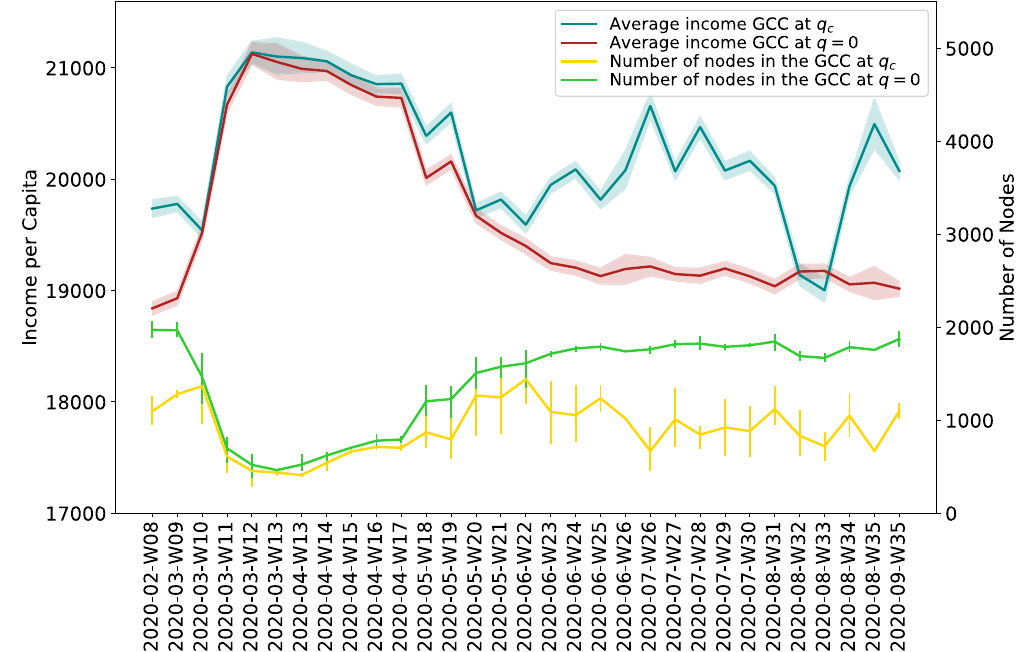
Figure 8. Average income per capita and total number of nodes in the GCC for every week of the period of observation. The GCC is either calculated at the start of the percolation process, i. e. without removing any nodes (GCC at q = 0 , red and green lines), or it is obtained by removing edges incrementally by weight until the optimal q is reached but before the GCC is dissolved (GCC at q c , blue and yellow lines). The lines represent the mean value of income per capita of the nodes or the total number of nodes in the GGC, averaged over one week of